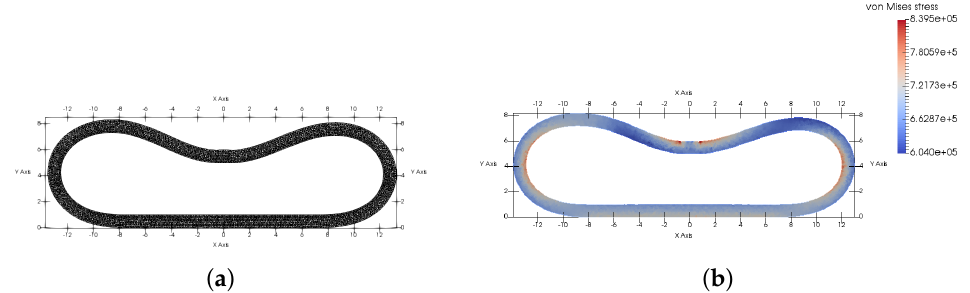
Figure 2. Ring, Neo-Hookean model: mesh deformation ( a ) and von Mises stress ( b ) after 14 increments.